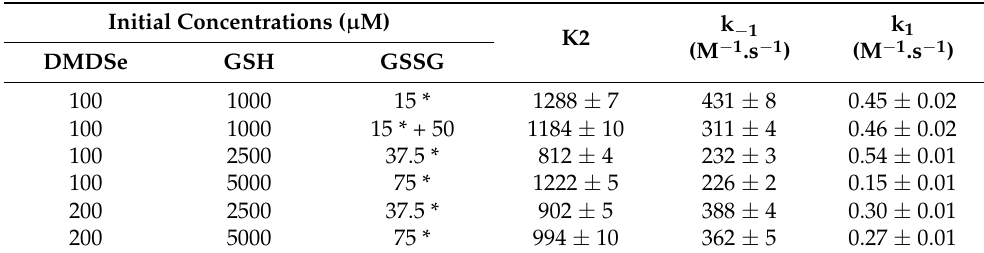
Table 1. Equilibrium and rate constants deduced from spectrophotometric experiments with mix- tures of DMDSe, GSH, and GSSG.